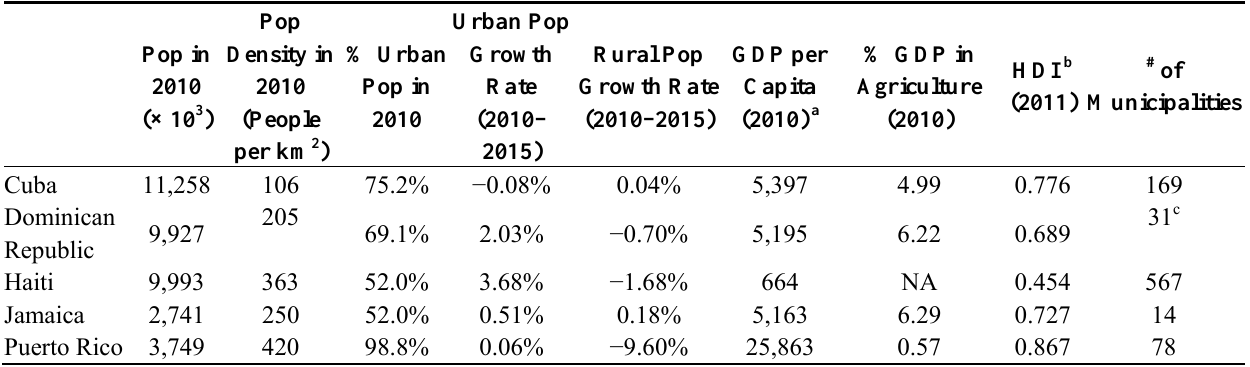
Table 1. Description of the principal demographic and socio-economic features of the Greater Antilles countries. Data are from